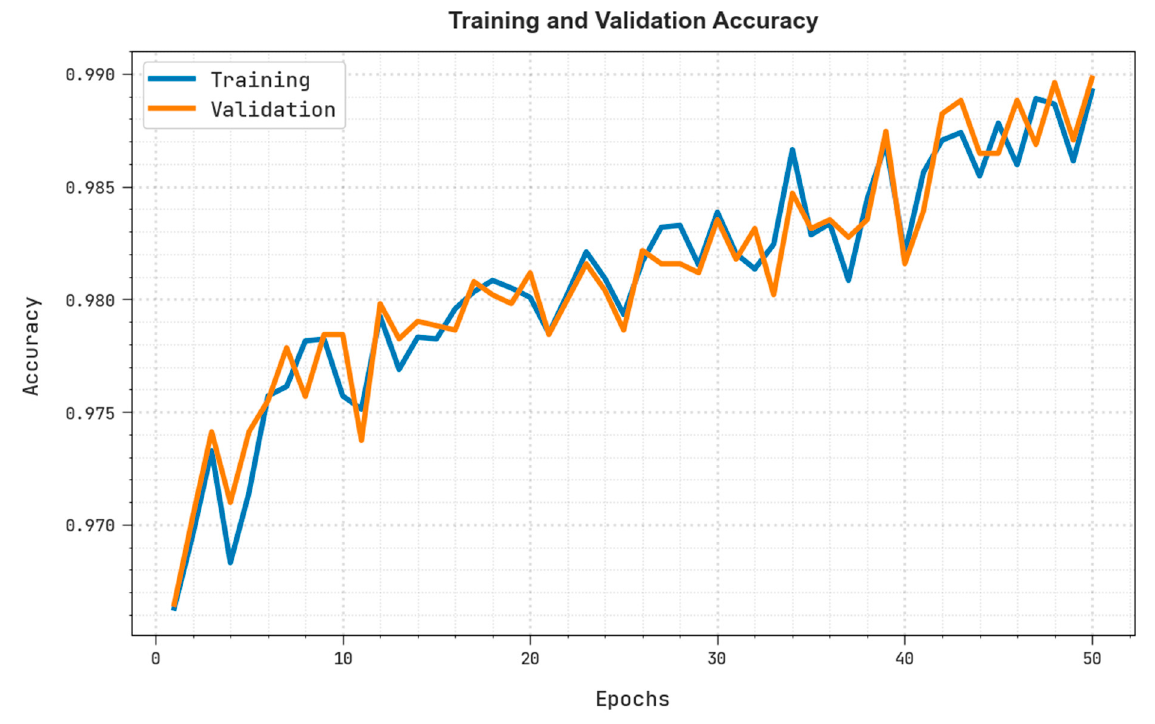
Figure 7. TRA and VLA analysis for BND-BMOML algorithm.